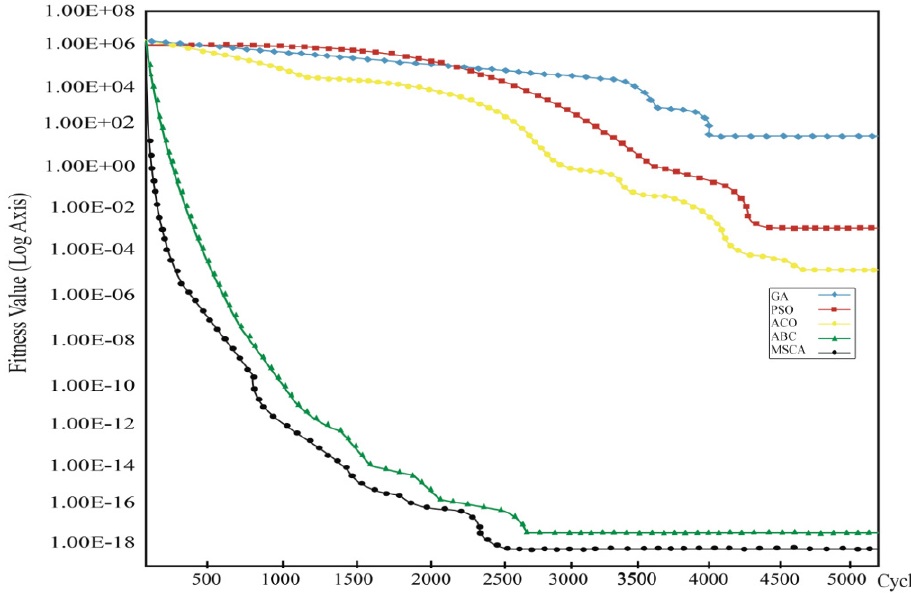
Figure 3. The results of applying different algorithms on Rosenbrock